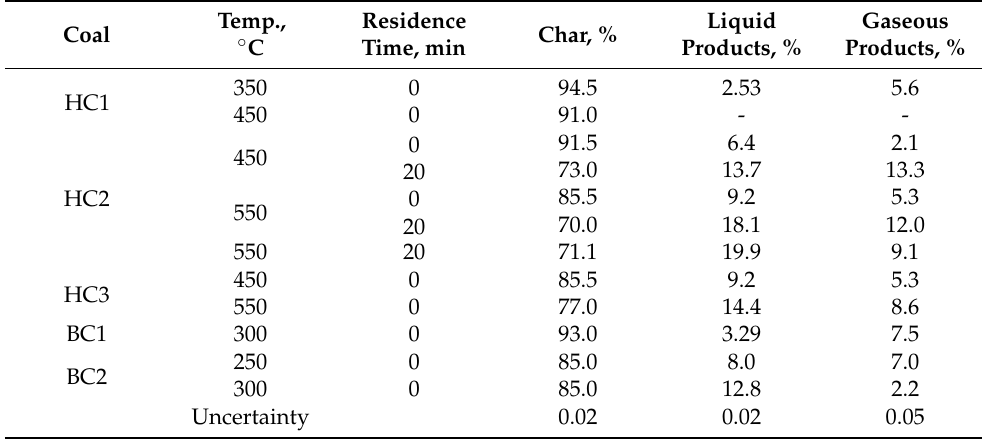
Table 6. Yields of the pyrolysis